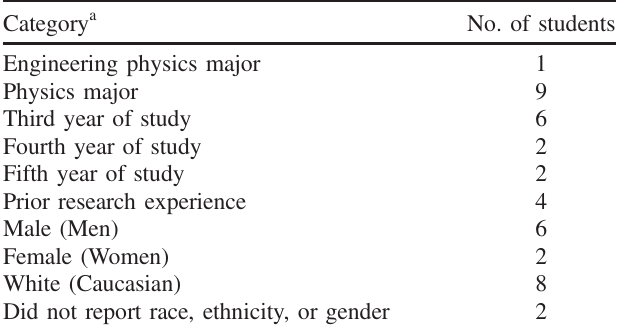
TABLE I. Demographic information of